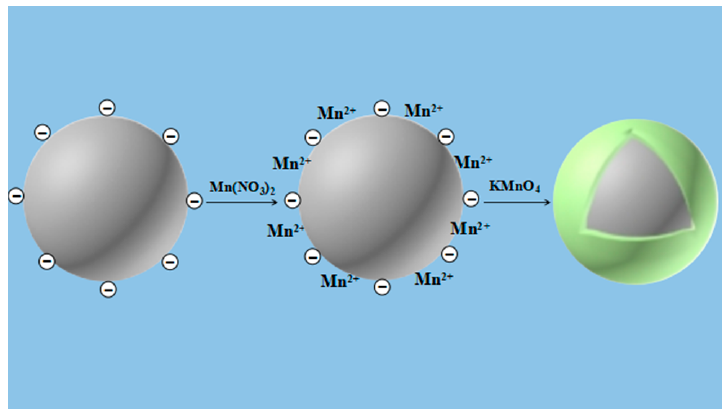
Figure 1. Schematic illustration of the synthesis process of the in-situ growth method.